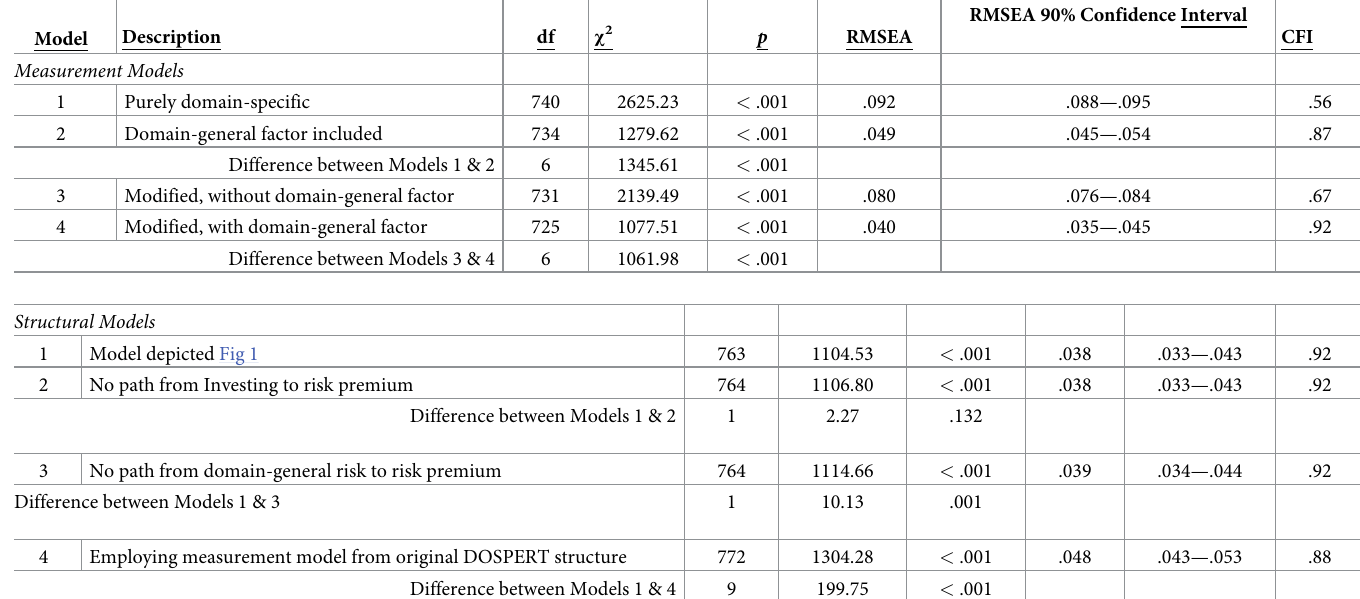
Table 1. Fit indices for models estimated using responses to the risk-behavior scale of the DOSPERT (N =